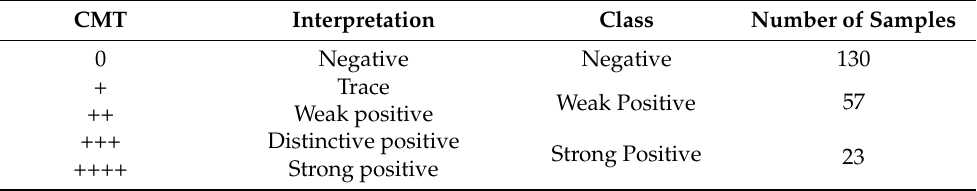
Table 1. Interpretation of results of CMT and grouping for classification algorithm.